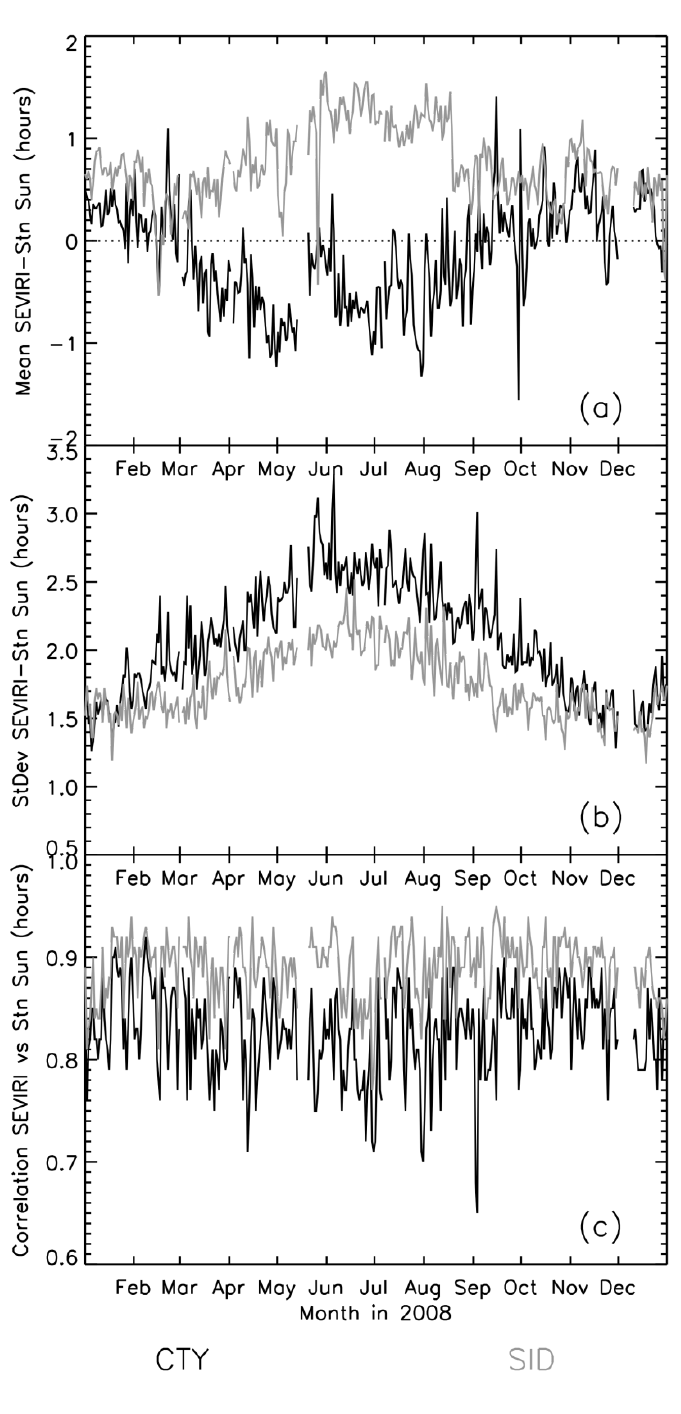
Figure 9. Time series of daily sunshine duration of SEVIRI minus station ( a ) mean difference and ( b ) standard deviations of differences. Panel ( c ) shows the corresponding SEVIRI vs . station correlations. Results are shown for both the SD-CTY (black) and SD-SID (grey)